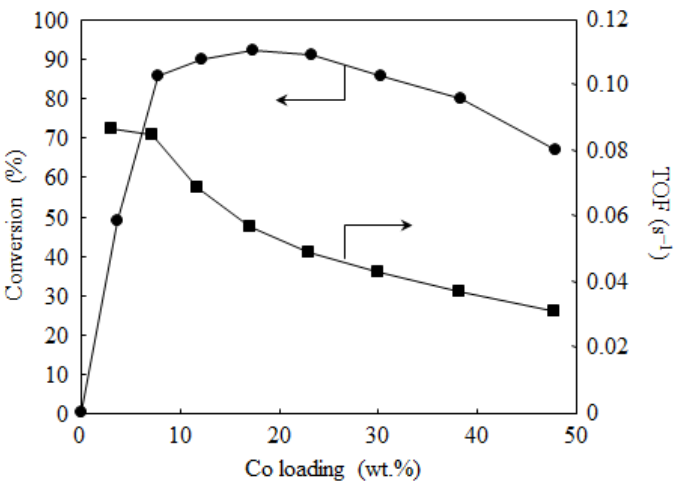
Figure 5. Effect of Co loading in the Co/CeO 2 (hp) catalyst for the steam reforming of ethanol at 673 K.